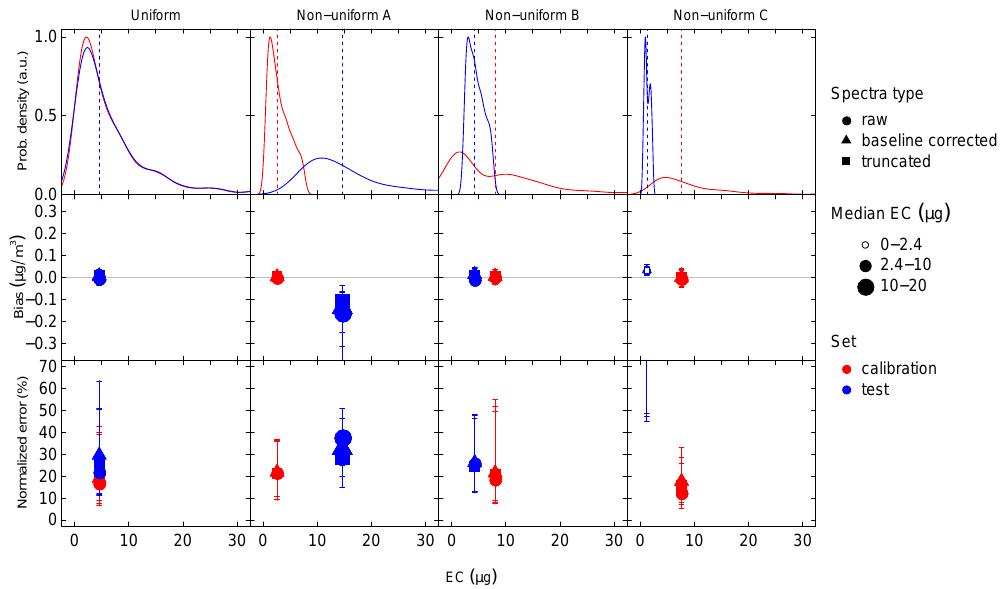
Figure 1. Uniform and Nonuniform EC calibrations. The probability density distribution of EC and bias and normalized error (with the interquartile range shown by error bars) in the calibration (red) and test (blue) sets for the Uniform EC case and three Nonuniform EC cases. Vertical lines are the median of the EC mass distributions color-coded for calibration and test